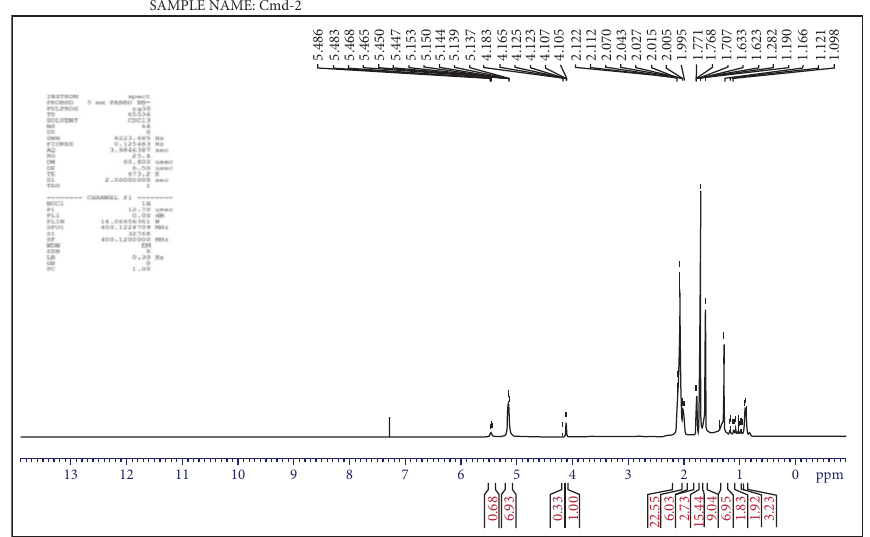
Figure 1: 1 H NMR spectrum analysis for compound 2.